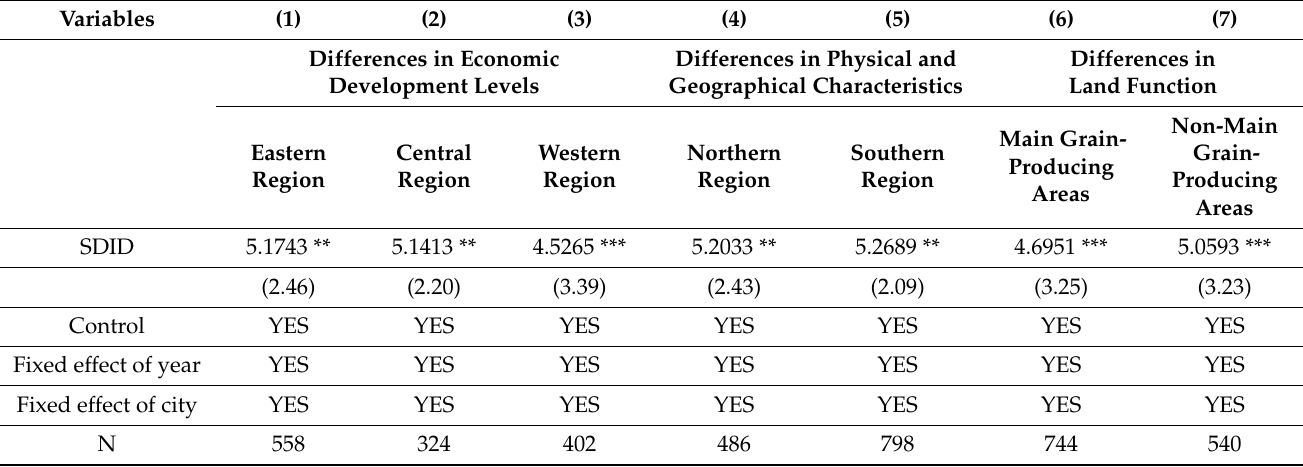
Table 5. Regional heterogeneity regression